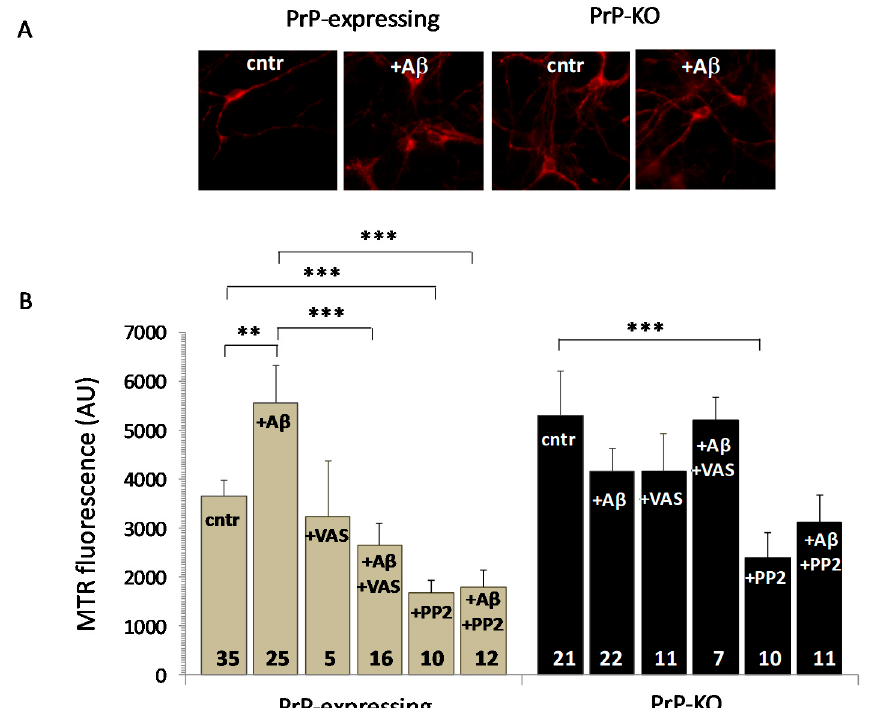
Figure 4. A β 1–42 causes a PrP-dependent mitochondrial ROS overload in PrP-expressing neurons through activation of NADPH oxidase. ( A , B ) Starting from the higher ROS quantity present in mitochondria of untreated PrP-KO neurons than in the PrP-expressing counterparts (cntr), A β addition ( + A β ) increases mitochondrial ROS only in PrP-expressing neurons as clearly demonstrated by the representative fluorescence micrographs of neurons loaded with the mitochondrial ROS-sensitive dye MTR and acquired with a 40 × objective ( A ), and the bar diagram reporting MTR fluorescence quantification ( B ). The source of such an A β -dependent supplementary ROS content in mitochondria of PrP-expressing neurons is the cytosolic NADPH oxidase, in light of ROS diminution upon inhibiting the enzyme with 3-benzyl-7-(2-benzoxazolyl)thio-1,2,3-triazolo(4,5-d)pyrimidine (VAS 2870, 10 µ M, 1 h, 37 ◦ C) ( + A β + VAS). Also addition of the Fyn inhibitor 3-(4-chlorophenyl) 1-(1,1-dimethylethyl)-1 H -pyrazolo(3,4-d)pyrimidin-4-amine (PP2, 10 µ M, 1 h, 37 ◦ C) reduces ROS presence in mitochondria of PrP-expressing neurons, either in the absence ( + PP2) or the presence of A β oligomers ( + A β + PP2). This is consistent with the uphill stimulation of NADPH oxidase by Fyn and the relieve of the PrP-dependent block of Fyn activation by A β oligomers (Figure 1). However, the drastic ROS diminution observed in PrP-KO neurons treated with PP2 ( + PP2), but not with VAS ( + VAS), indicates that other Fyn-controlled (and PrP- and NADPH oxidase-independent) pro-oxidant pathways contribute to mitochondrial ROS accumulation. ** p < 0.01, *** p < 0.001 (Student ′ s t -test). Other details are as in the legend to Figures 1 and 2.